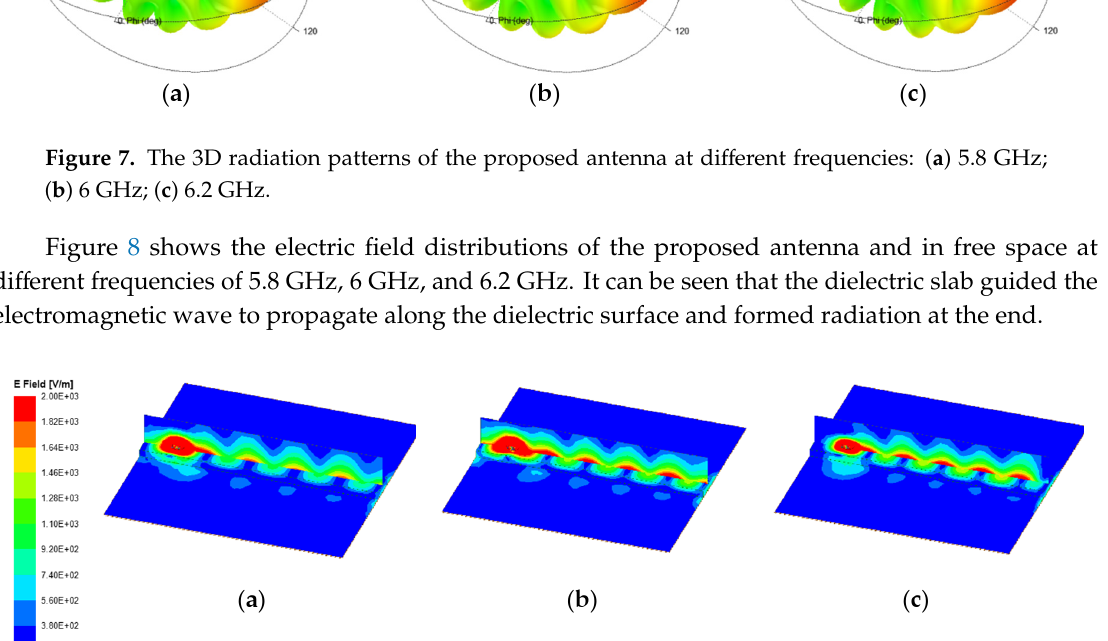
( b ) ( c ) Figure 9. Photograph of the proposed surface wave antenna prototype and test environment: ( a ) top view; ( b ) bottom view; ( c ) side view; ( d ) anechoic chamber. 3.1. Reflection Confficient Figure 10 shows the simulated and measured reflection coefficient ( S 11 ) results. S 11 was less than -10 dB between the frequency range from 5.81 to 6.36 GHz for the simulated result and from 5.89 to 6.33 GHz for the measured one. The disagreements are mainly due to the inconsistencies between the electrical parameters of the actually used dielectric materials and the one used in simulations. We simulated different permittivity and found that the resonant frequency point will shift from 6.25 GHz to 6.2 GHz when the permittivity is changed to 10 from 9.8, which is consistent with the measured curve. The other unpredictable factors, such as the fabrication and assembling tolerances, and the alignment error of our measurement setup will also cause these disagreements.